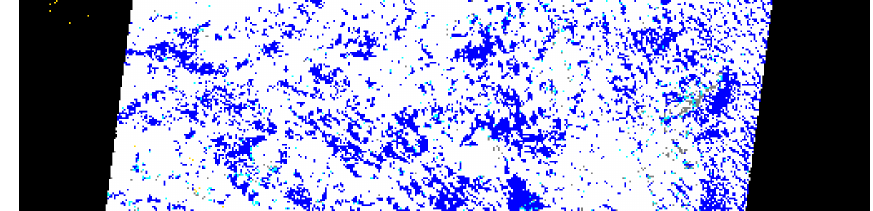
Figure 10. Map of the final updated (Stage D) MISR RCCM for Path 168, Orbit 1412, Block 108 and camera BF. Missing pixels have been replaced by estimates of the cloud or clear status of the observed areas, based on the cloudiness level of neighboring cameras and neighboring pixels within small subwindows of the target camera, as described in the text. The enlargement and linear dimensions of the mapped area are identical to those indicated in Fig. 3, while color coding is identical to that indicated in Fig. 9.